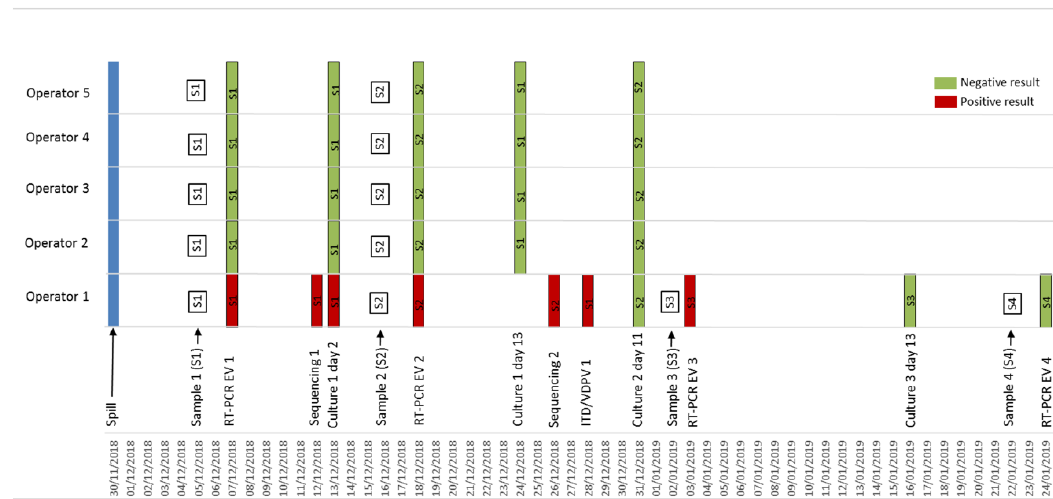
Figure 1. Timeline of the monitoring of vaccine poliovirus-exposed operators following an accidental spill of Sabin PV3, France, November 2018. S1: day 5 samples (throat and stool); S2: day 16 stool samples, S3: day 33 stool sample, S4: day 53 stool sample. The monitoring was performed on the 5 exposed operators from day 5 post-exposure to the end of detection of Sabin PV3 in the stool of the infected operator. Data are presented as a timeline with dates of sampling and tests’ results.